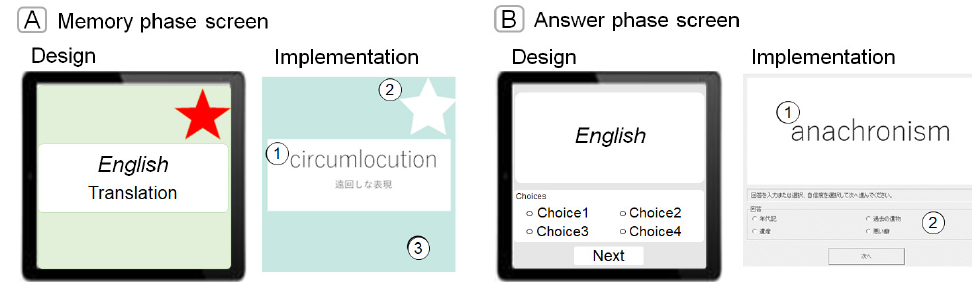
Figure 3. Memorization support application screen. ( A ) Memory phase screen. ( B ) Answer phase screen. (Other) The order of execution of the memorization target on the memory phase screen and the answer phase screen is the same as shown in Figure